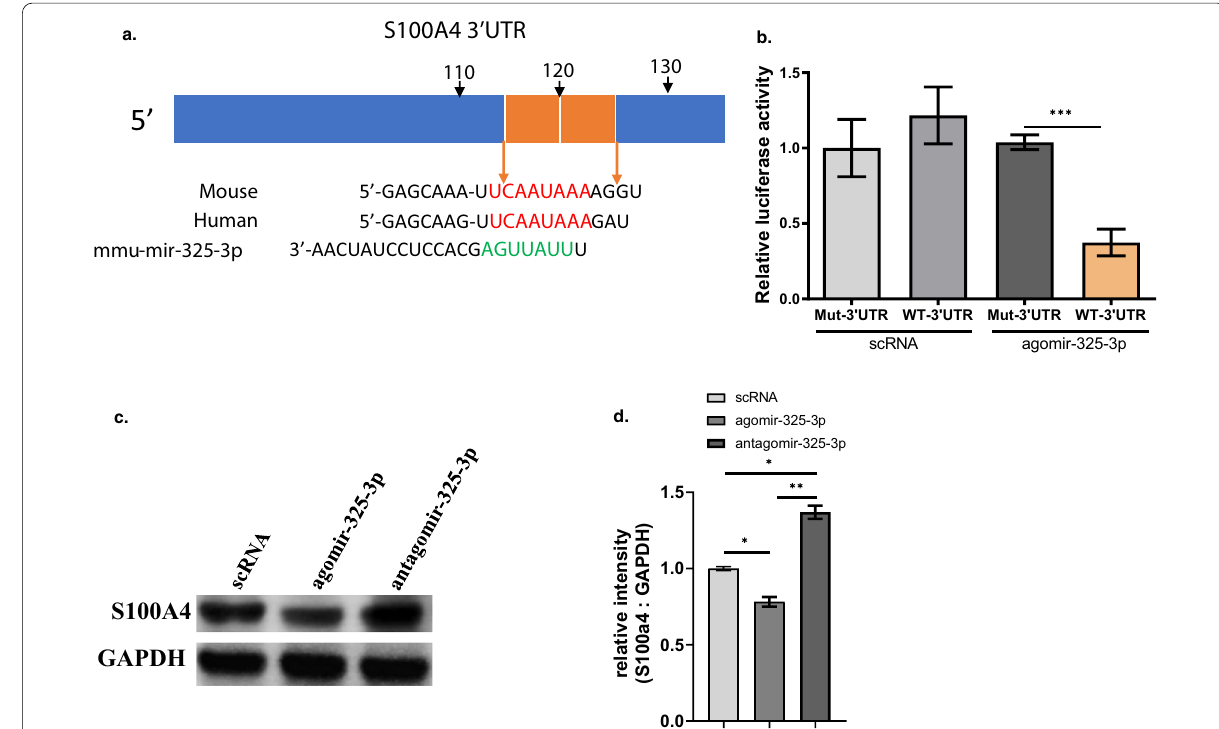
Fig. 3 MiR-325-3p directly targets S100A4. a The complementary sequences of miR-325-3p were identified in 3 ′ UTR of S100A4 mRNA using TargetScan. b miR-325-3p inversely modulated the luciferase activity of plasmids containing WT 3 ′ UTR of S100A4 (WT, Wild Type; Mut, Mutant Type) (mean SD). c The protein level of S100A4 in OCPs transfected with agomir-325-3p, antagomir-325-3p or their controls were tested by Western blot. ± d The relative intensity of S100A4 comparing with GAPDH in ( c ) was quantified (mean *p < 0.05, **p < 0.01, ***p <